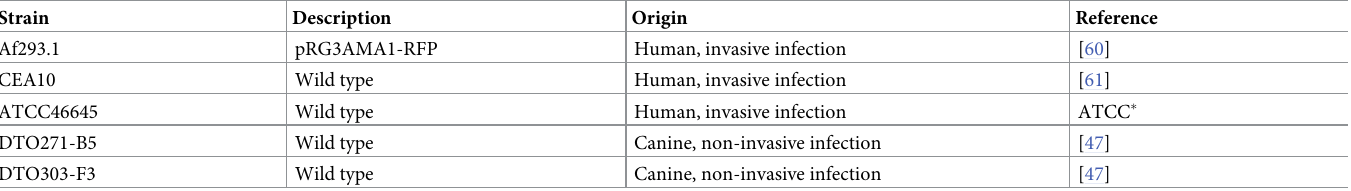
Table 3. Strains used in this